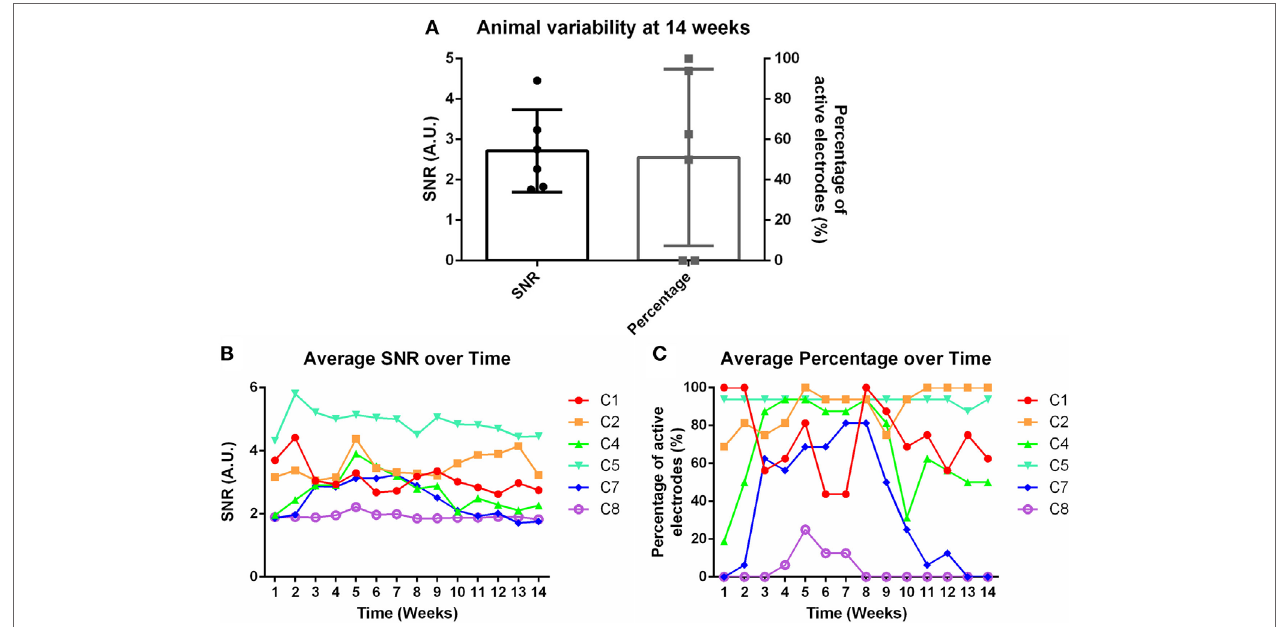
FigUre 2 | (a) Animal variability at 14 weeks demonstrated through signal-to-noise ratio (SNR) and percentage of active electrodes. (b) Average SNR and (c) average percentage of active electrodes over time for individual